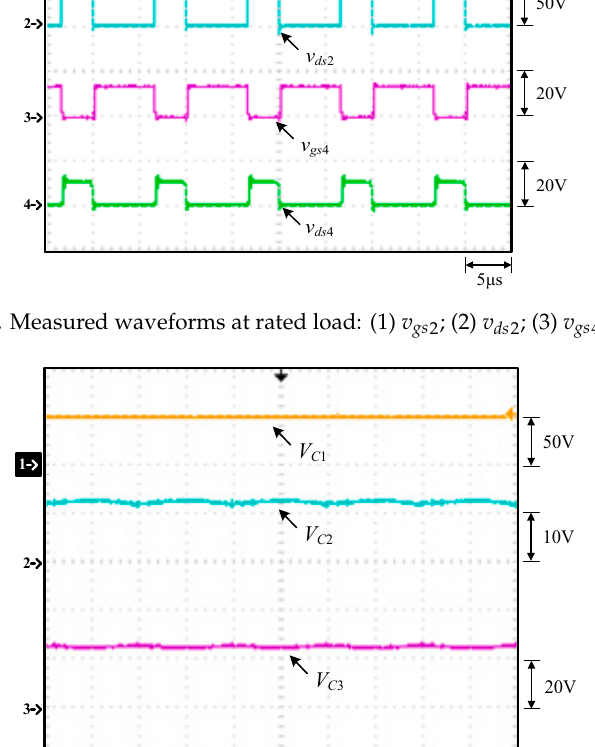
Figure 17. Measured waveforms at rated load: (1) V C 1 ; (2) V C 2 ; (3) V C 3 .